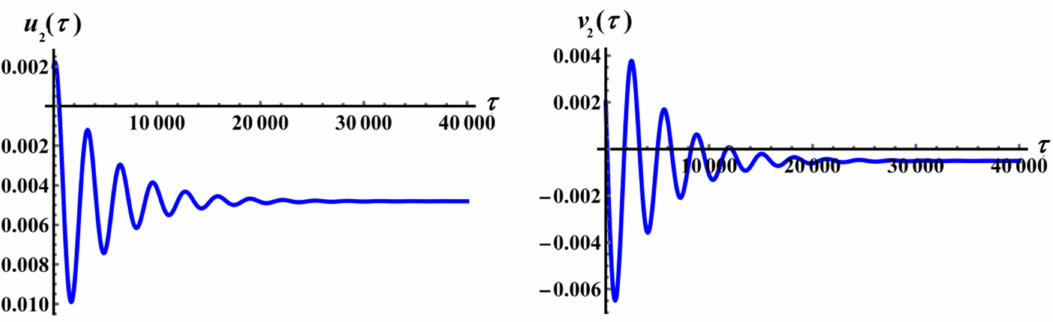
Figure 25. The time histories of u 2 and v 2 .